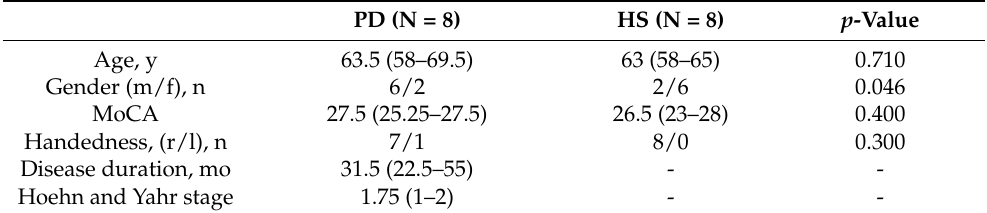
Table 1. Persons with Parkinson’s Disease (PD) and healthy participants (HS)—Clinical and demo- graphic